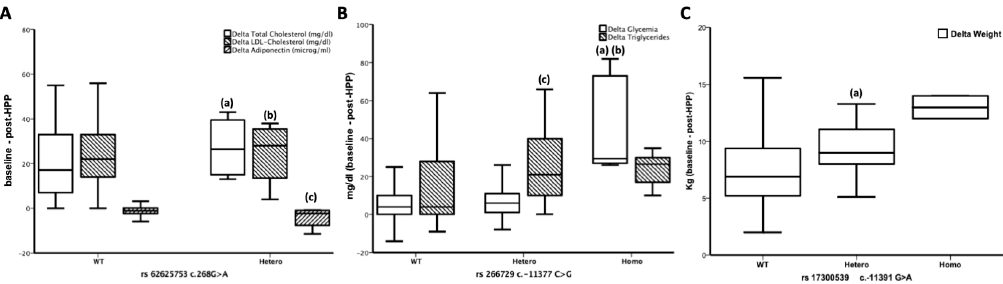
Figure 2. ( A ) Di ff erences in ∆ Total Cholesterol, ∆ LDL Cholesterol and ∆ adiponectin among the three groups based on rs62625753 polymorphism. At the end of a 4-weeks HPP in respect to baseline, the Heterozygous showed a significantly greater reduction in (a) Total Cholesterol ( p = 0.010), and in (b) LDL Cholesterol ( p = 0.036) than WT, with a significant increase in (c) adiponectin levels ( p = 0.005). ( B ) Di ff erences in ∆ Glycemia and Triglycerides among the three groups based on rs266729c polymorphism. At the end of 4-weeks HPP in respect to baseline, the Homozygous showed a significantly greater reduction in Glycemia levels than both (a) WT ( p < 0.0001) and (b) Heterozygous ( p < 0.0001). On regard to Triglycerides levels, the Heterozygous showed a significantly greater reduction than (c) WT ( p < 0.0001). ( C ) Di ff erences in ∆ Weight among the three groups based on rs17300539 polymorphism. At the end of a 4-weeks HPP compared to baseline, the Heterozygous showed a significantly greater reduction ( p = 029) in weight than (a) WT. Although an increasing trend was found in Homozygous no significant results were found because of the small size of this group ( n = 2 patients).